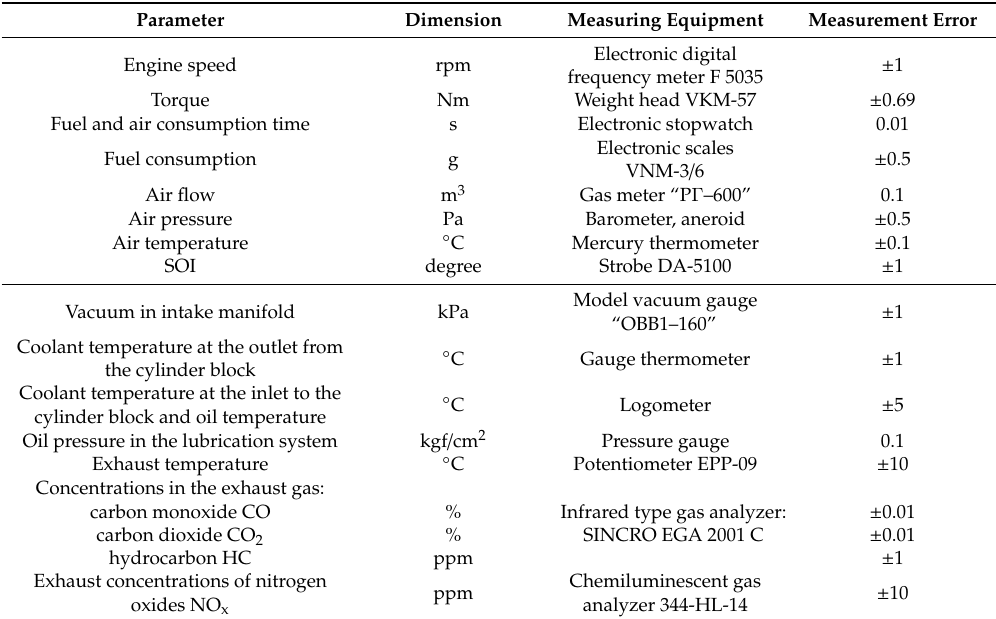
Table 2. Equipment and measurement accuracy.